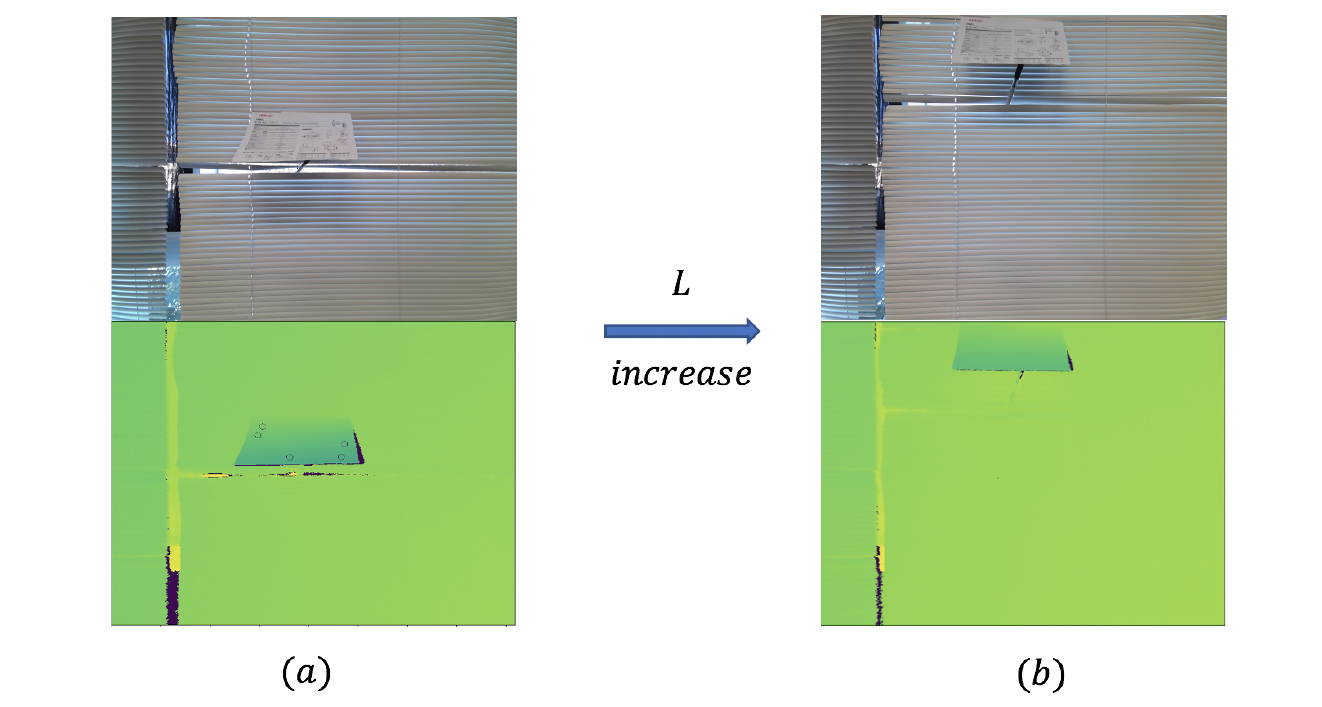
Figure 22. Displacement from center as increasing L : ( a ) → ( b )